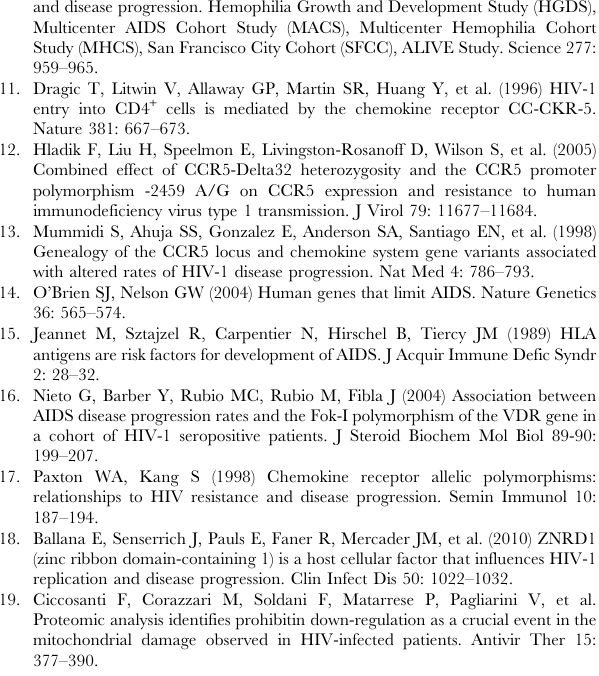
Table S2 MicroRNAs under expressed in HIV-1 NL43 infected cultures compared to uninfected control